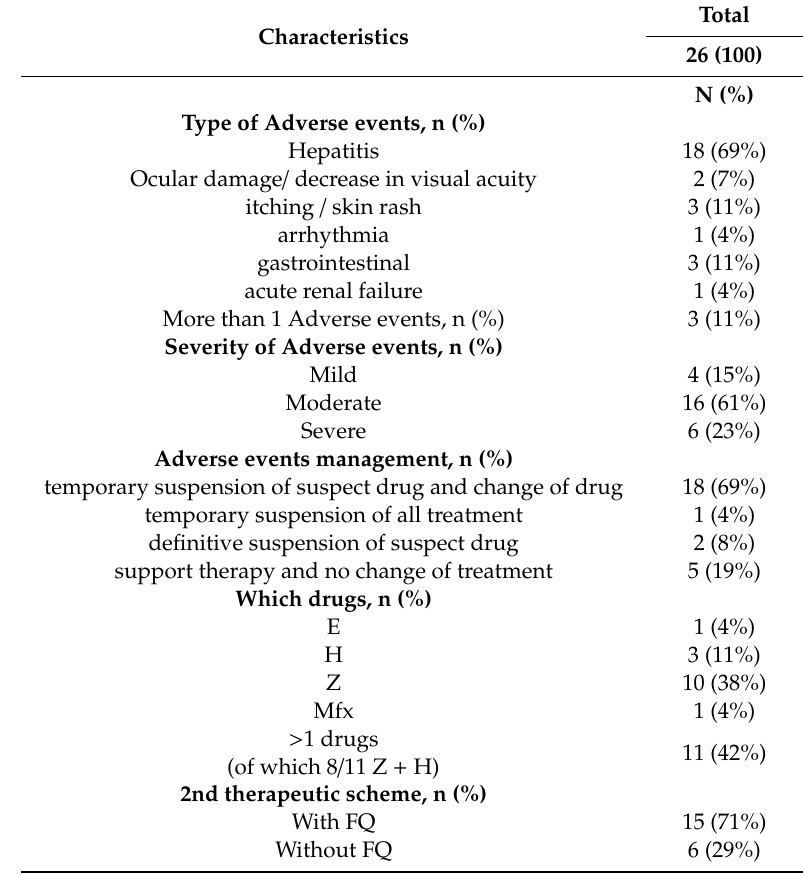
Table 2. Characteristics of adverse events in the 26 patients who reported them.